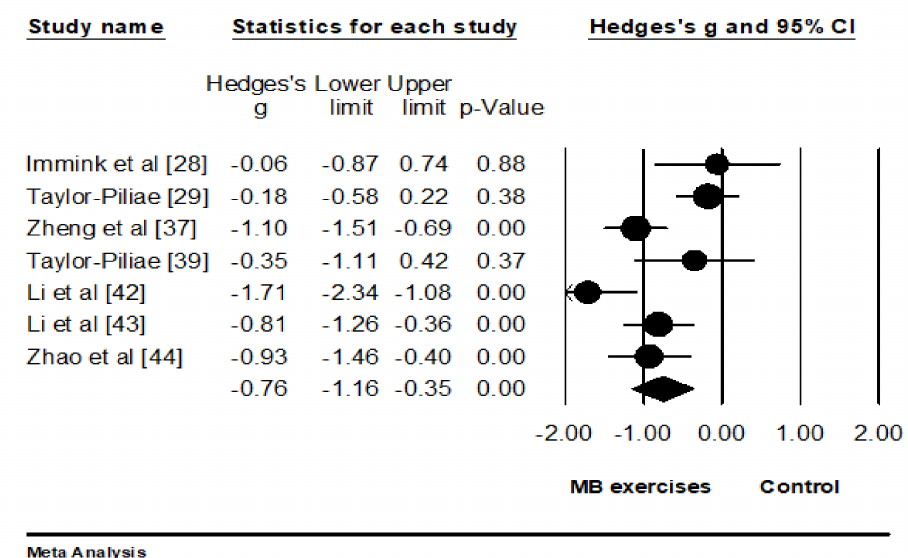
Figure 2. Effect of mind-body exercises on depression. (Circled symbol represents the effect size of each individual study and squared symbol represents an overall/pooled effect size of all studies on each outcome).